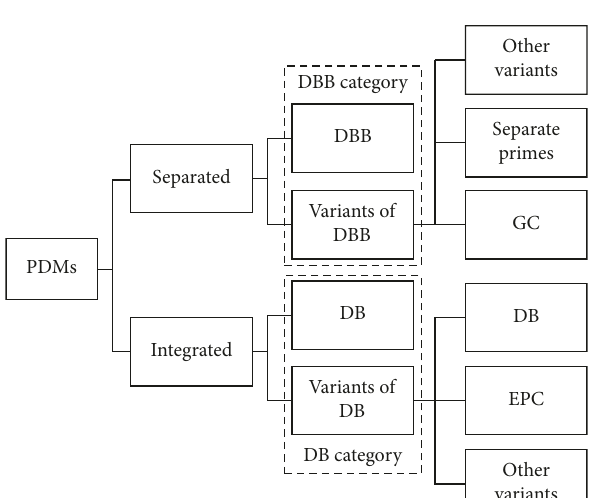
Figure 2: Alternative PDMs.